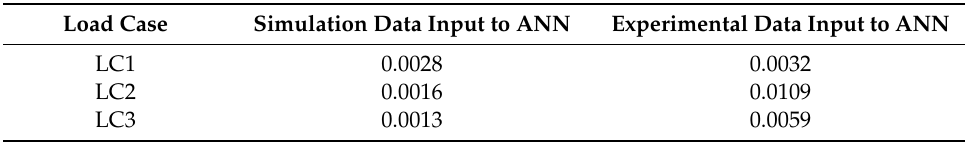
Figure 12. Results of testing ANN with experimental and simulation data: ( a ) load case LC1; ( b ) load case LC2; and ( c ) load case LC3. Table 7. Root-mean-square-errors between exact and approximated by ANN values of ISF during o ff -line testing of the